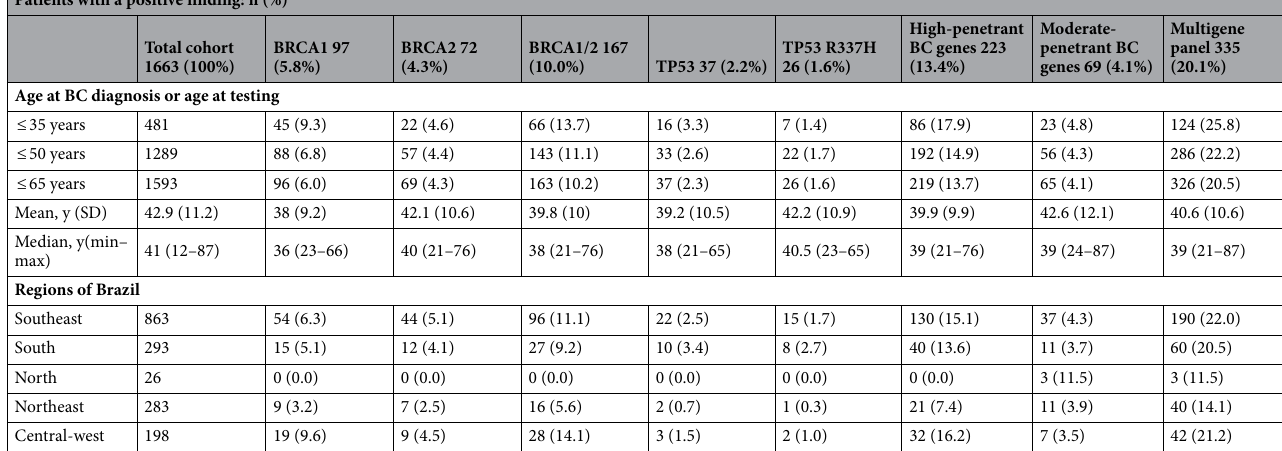
Table 1. Number of carriers of P/LP germline variants according to age and living country region. High- penetrant genes: BRCA1 , BRCA2 , CDH1 , NF1 , PALB2 , PTEN , STK11 and TP53 . Moderate-penetrant genes: ATM , BARD1 , BRIP1 , CHEK2 , RAD51C and RAD51D . Positive findings: carriers of likely pathogenic and pathogenic variants. BC breast cancer, SD standard deviation, y